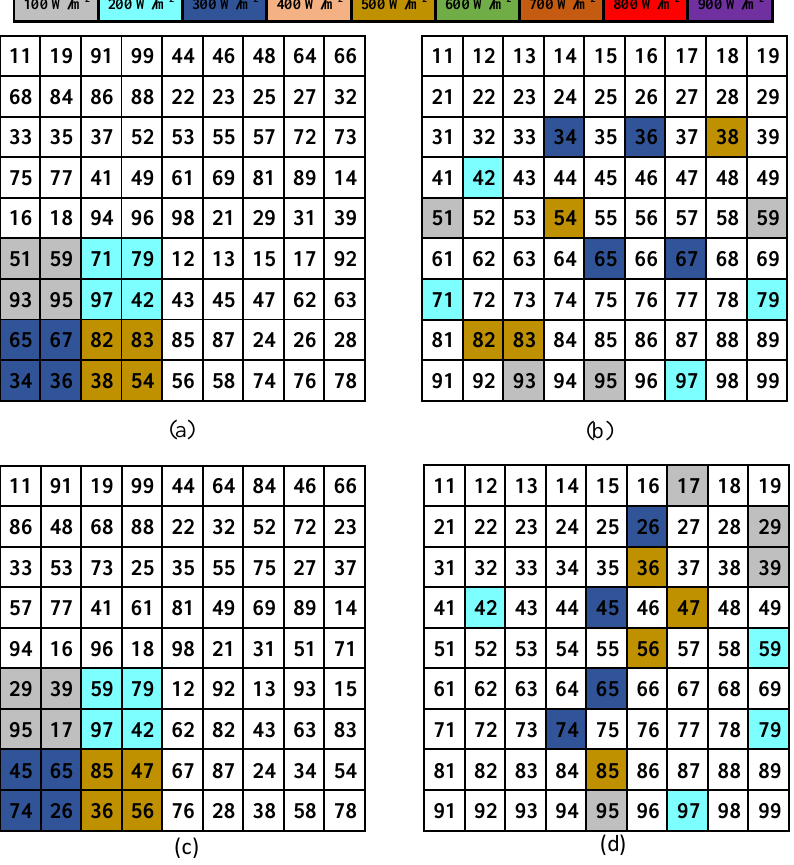
In Case-IV, in the Bottom-Right corner, 16 PV modules are partially shaded, as seen in the Figure 8a.